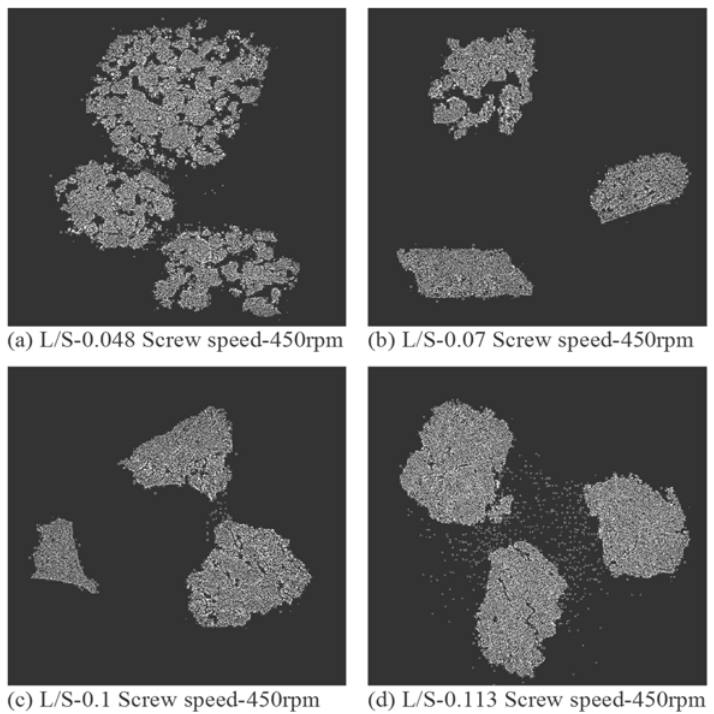
Figure 13. X ‐ ray tomographic images of granules produced using Pearlitol 300DC at varying L/S (screw speed, 450 rpm).